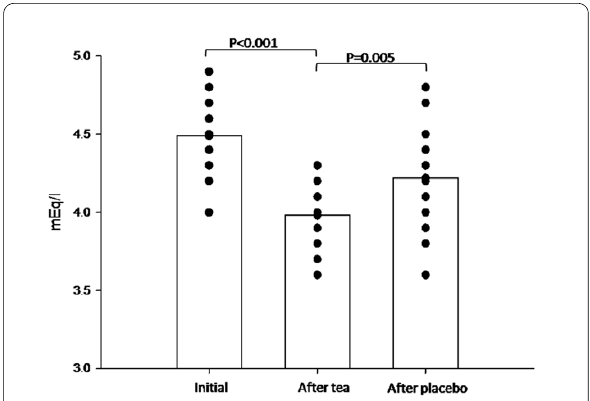
Figure 4 Serum potassium: individual data and mean values ac- cording to treatment period